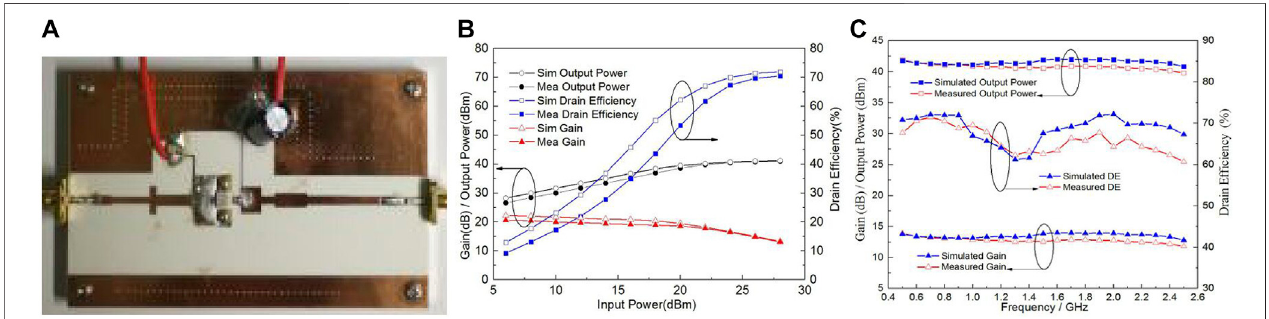
FIGURE3|(A) PhotographoftheproposedPA. (B) Simulated and measured drainef fi ciency,output power,and gainvirusinputpower at0.8 GHz. (C) Simulated and measured drain ef fi ciency, output power, and gains of the designed PA.